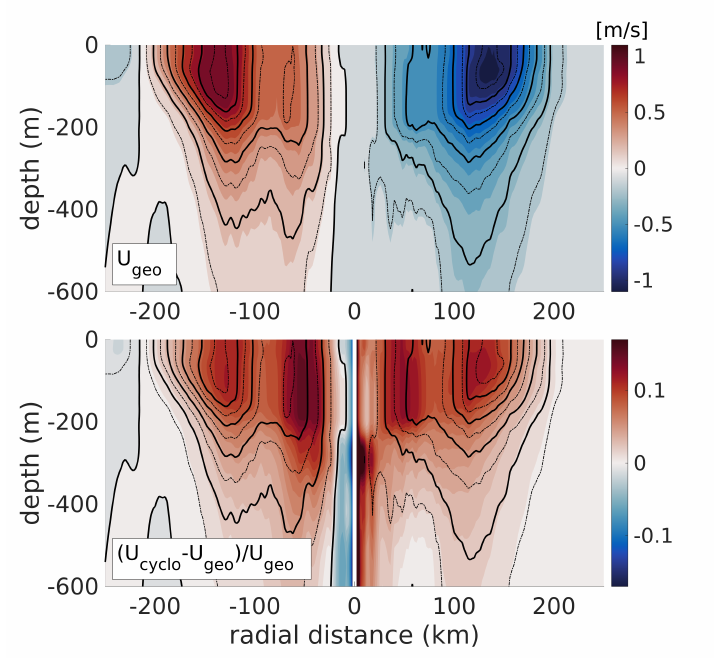
Figure 10. top panel: Cyclogeostrophic velocity section, using the relocated glider data. The thin dashed contours are plotted every 0.125 m s − 1 and the thick continuous black contours every 0.25 m s − 1 . bottom panel: Relative difference between the cyclogeostrophic velocity and the geostrophic velocity. The cyclogeostrophic velocity contours are shown as in the top